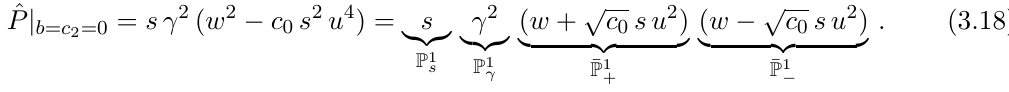
Kodaira (cid:12)ber where 0